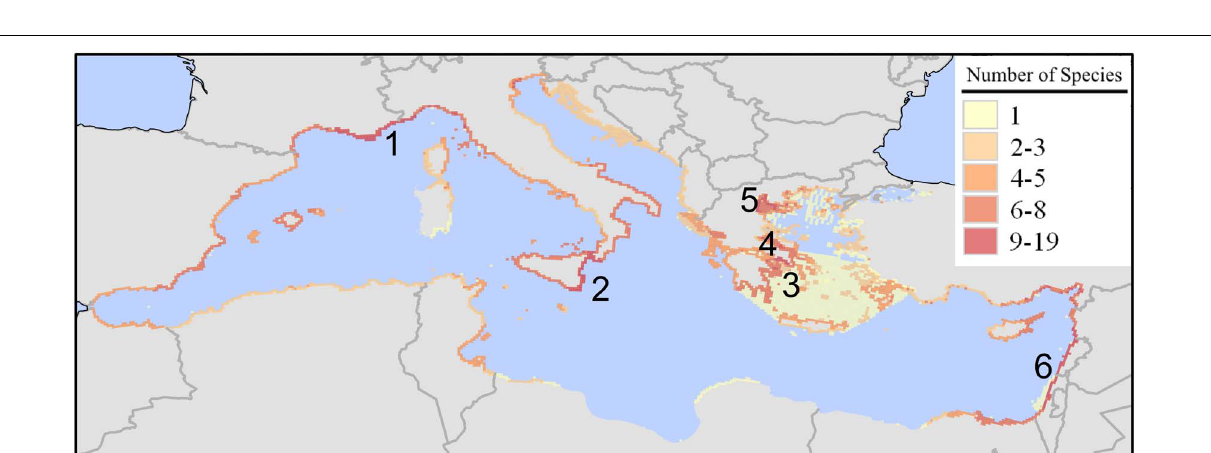
Mediterranean coastline from Martigues and Marseille (France) to Genova (Italy); (2) eastern Sicily; (3) Saronikos Gulf; (4) Evvoikos Gulf; (5) Thermaikos Gulf; (6) the coastlines of SE Turkey, Syria, Israel, and